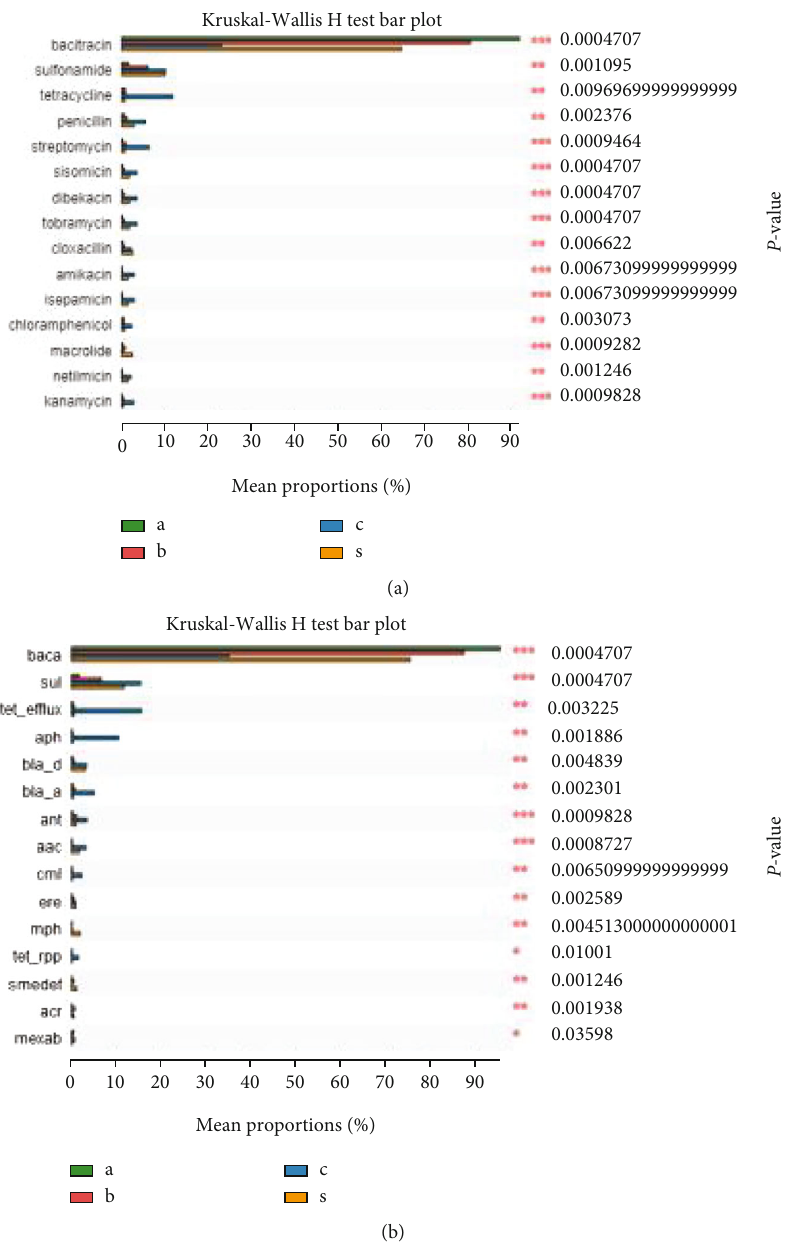
Figure 5: (a, b) Kruskal-Wallis H test bar plot components of